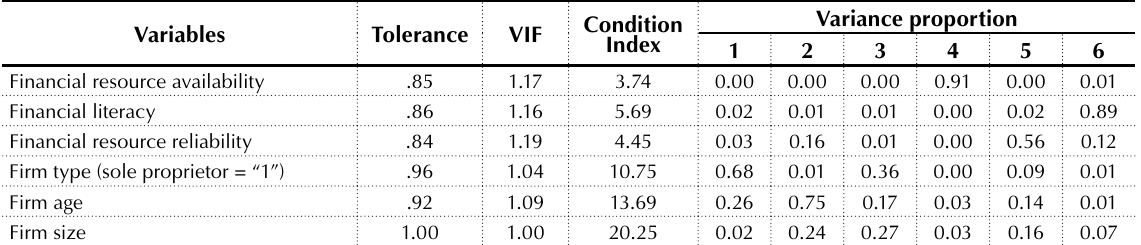
Source: Survey data.